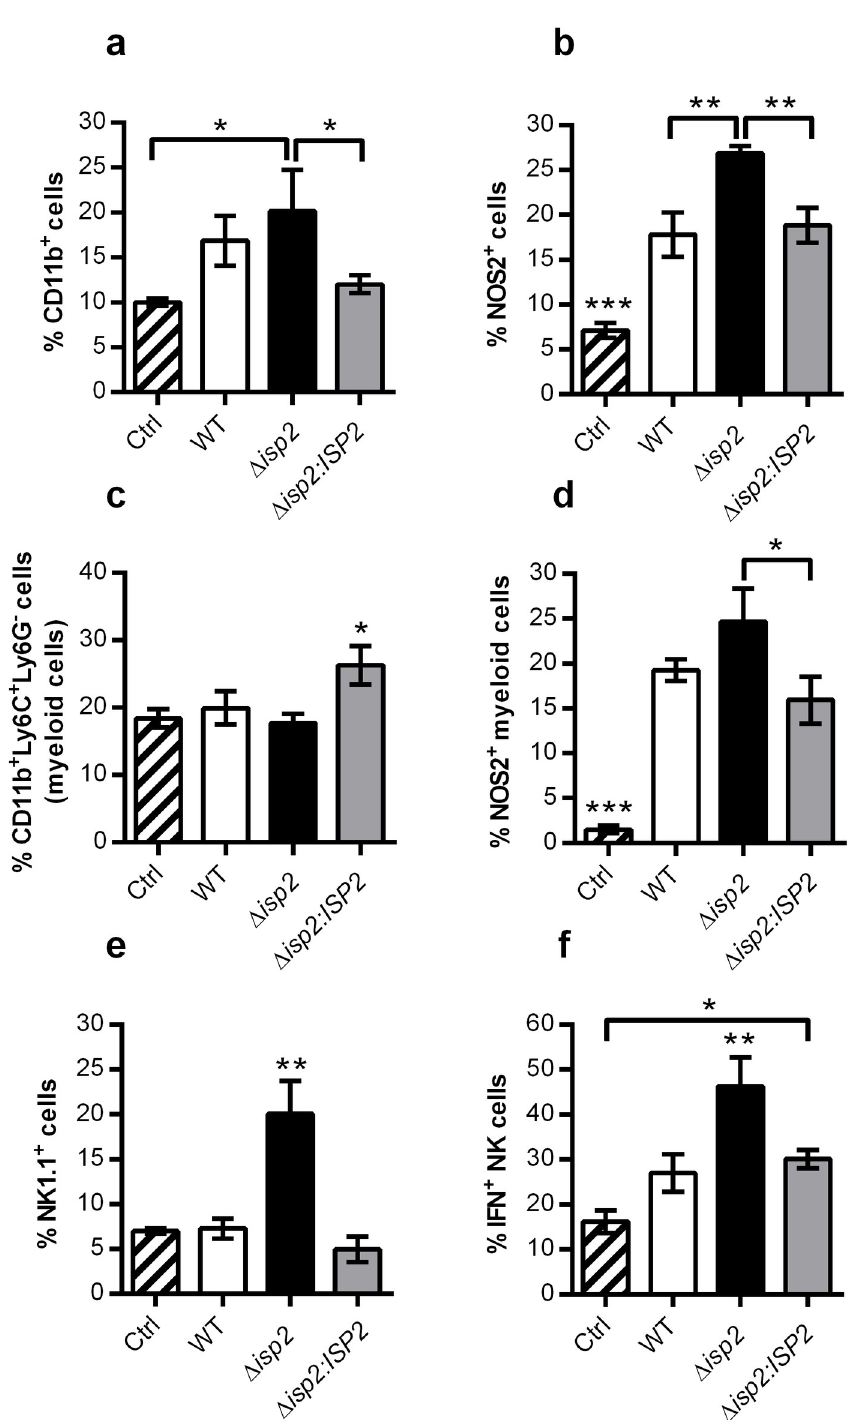
Fig 7. Enhanced NOS2 + and IFN- γ + populations in the spleen of mice infected with Δ isp2 T . b . rhodesiense during early infection. C57BL/6 mice were infected intraperitoneally with 1 × 10 5 T . b . rhodesiense WT, Δ isp2 and Δ isp2 : ISP2 . Uninfected mice were used as a control (Ctrl). After 4 days, mice were euthanized, perfused, and the spleens were removed and homogenized. Cell suspensions were incubated with monensin for 4 h then stained with antibodies against extracellular and intracellular antigens for flow cytometry to assess the percentage of cell subsets. Cells were first gated to exclude debris using a FSC vs. SSC plot followed by FSC-H vs. FSC-A to exclude doublets. For (a-d) CD11b + cells were selected from a SSC vs. FITC-CD11b plot, then Ly6C + Ly6G - (myeloid) cells were identified using